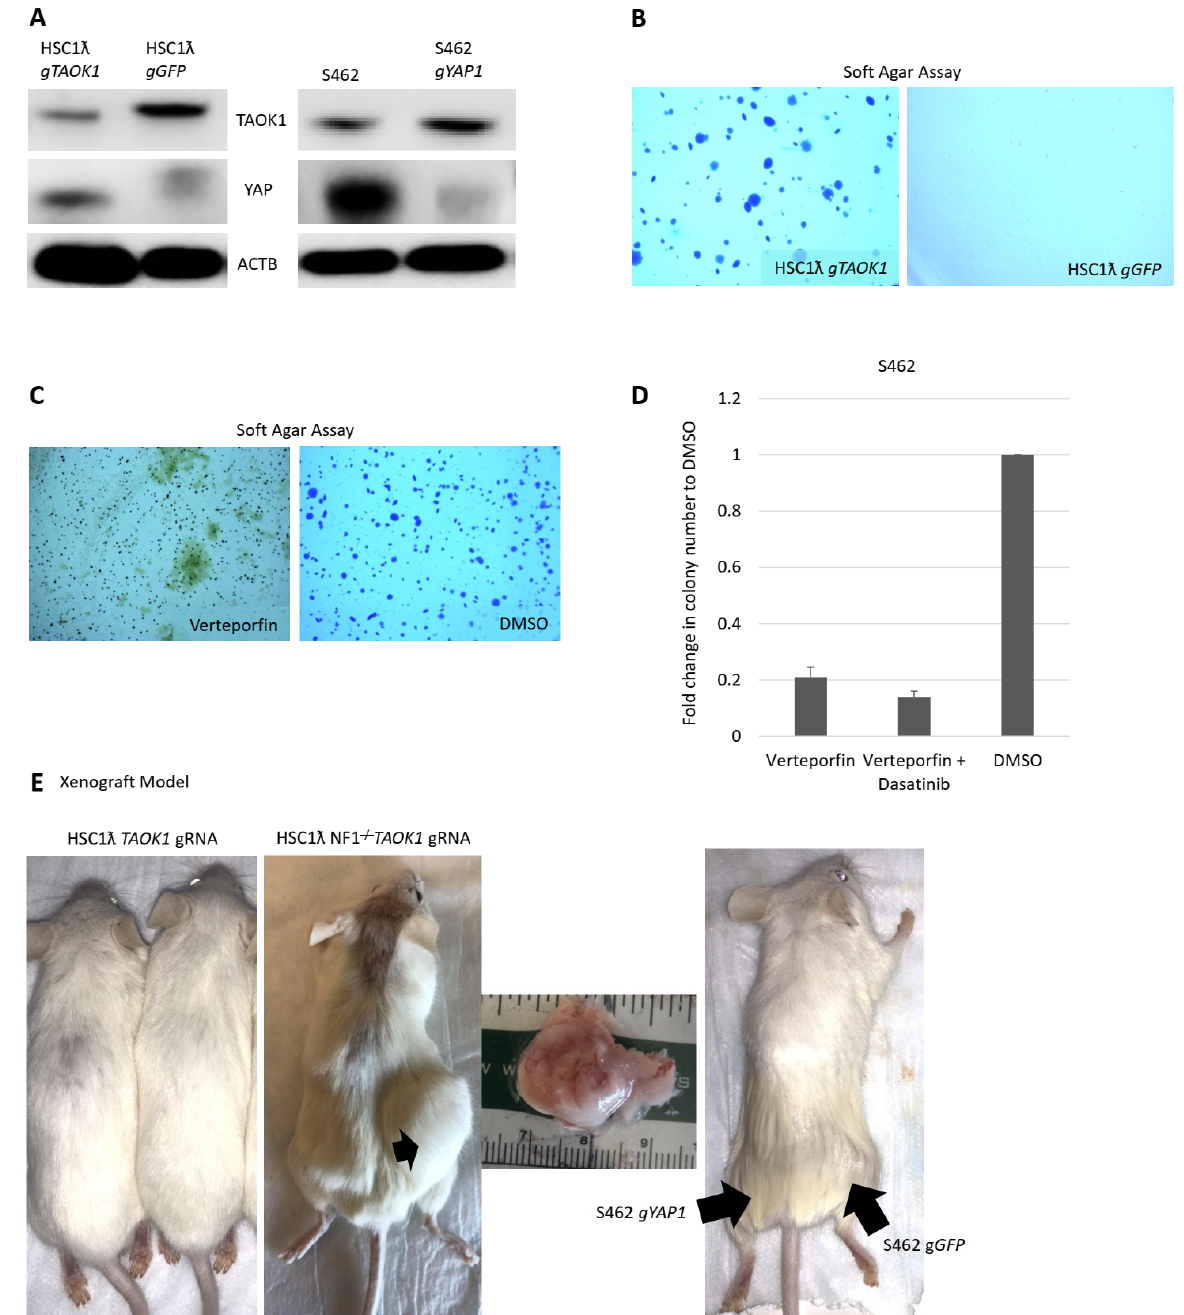
Figure 2. TAOK1 is a Schwann cell tumor suppressor gene. ( A ) Western blot showing TAOK1 decreased levels and increased YAP levels upon gRNA against TAOK1 in a human immortalized Schwann cell line and loss of YAP Western blot in the MPNST cell line S462. ( B ) Anchorage-independent assay showing cell transformation upon TAOK1 knockout in ( C ) and anoikis upon treatment with verteporfin (2× magnification). ( D ) Inhibition of YAP/TAZ activity and tyrosine kinase inhibition results in loss of anchorage-independent growth. ( E ) Tumor formation in NRG mice.